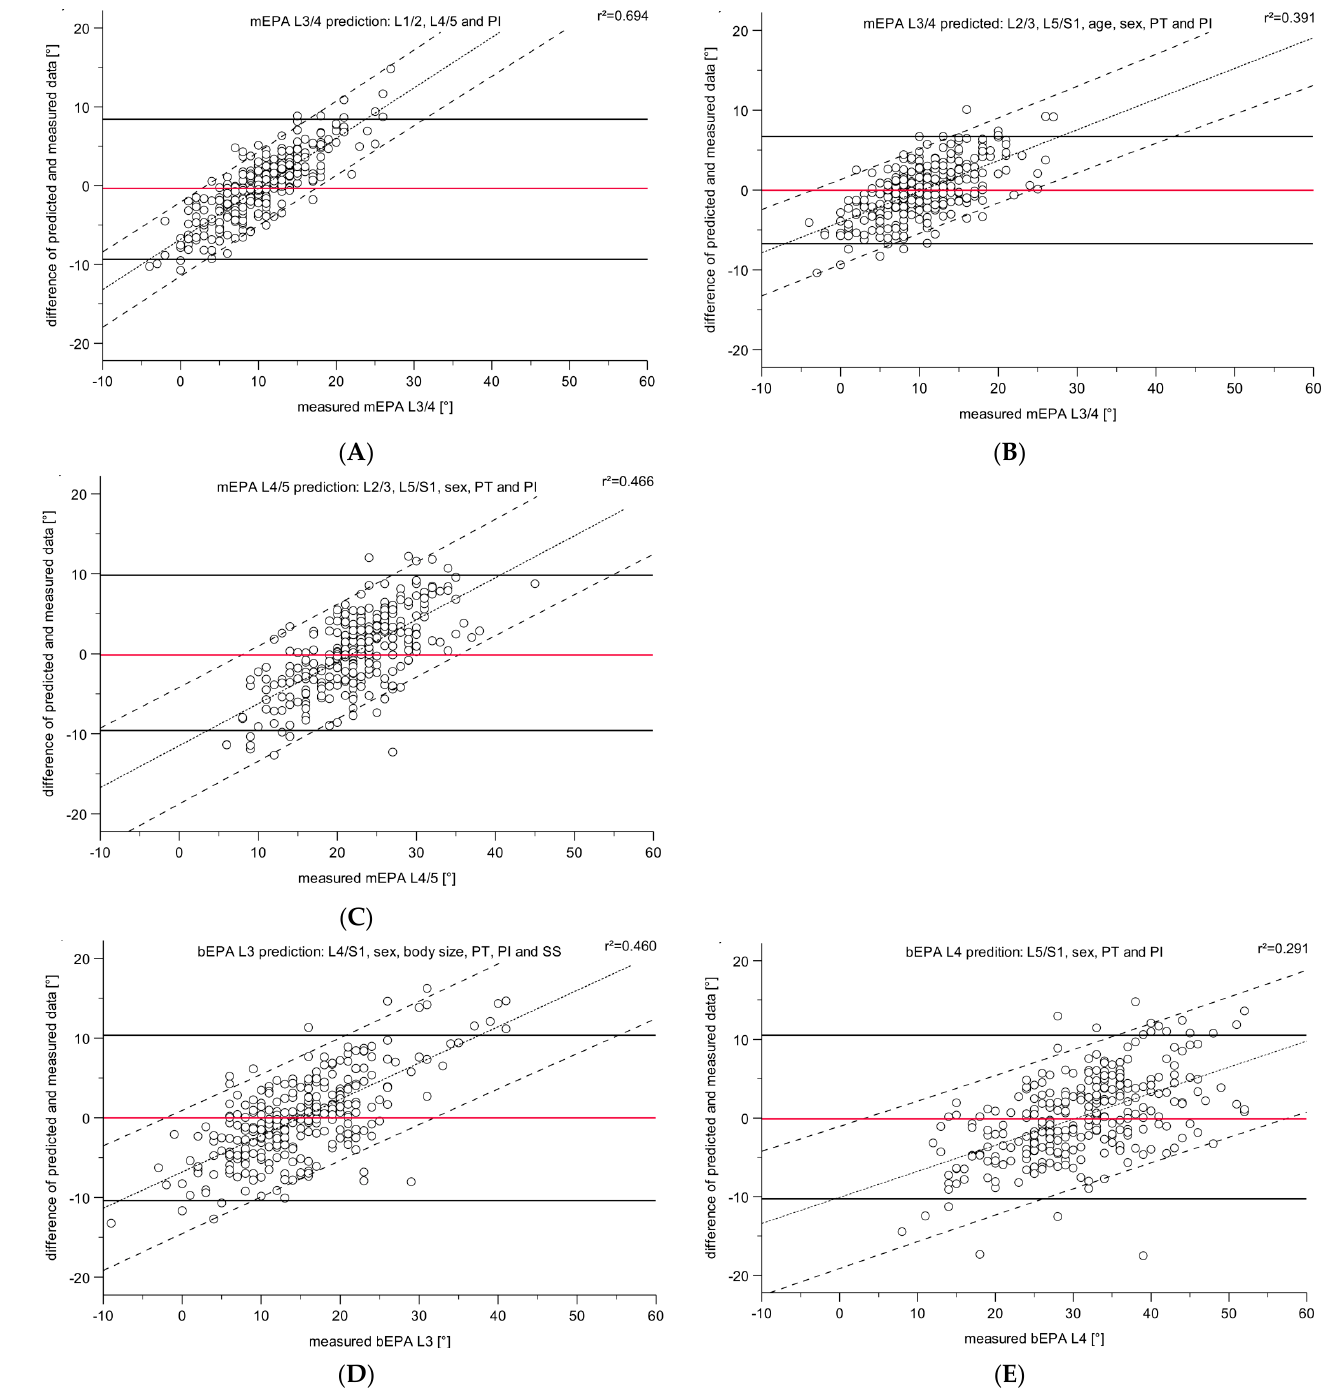
Figure 3. Difference plots of the measured mEPA (( A ): L3/4, ( B ): L3/4, ( C ): L4/5) and bEPA (( D ): L3, ( E ): L4) and their difference from the predicted monosegmental (mEPA) and bisegmental endplate angles (bEPA), respectively. Horizontal lines are the limits of agreement (black) and the mean difference (red); dotted and dashed lines are the regression line and their 0.95% confidence intervals. To detect the dependency of differences between measured and predicted angles, R 2 is given in the upper right corner of each